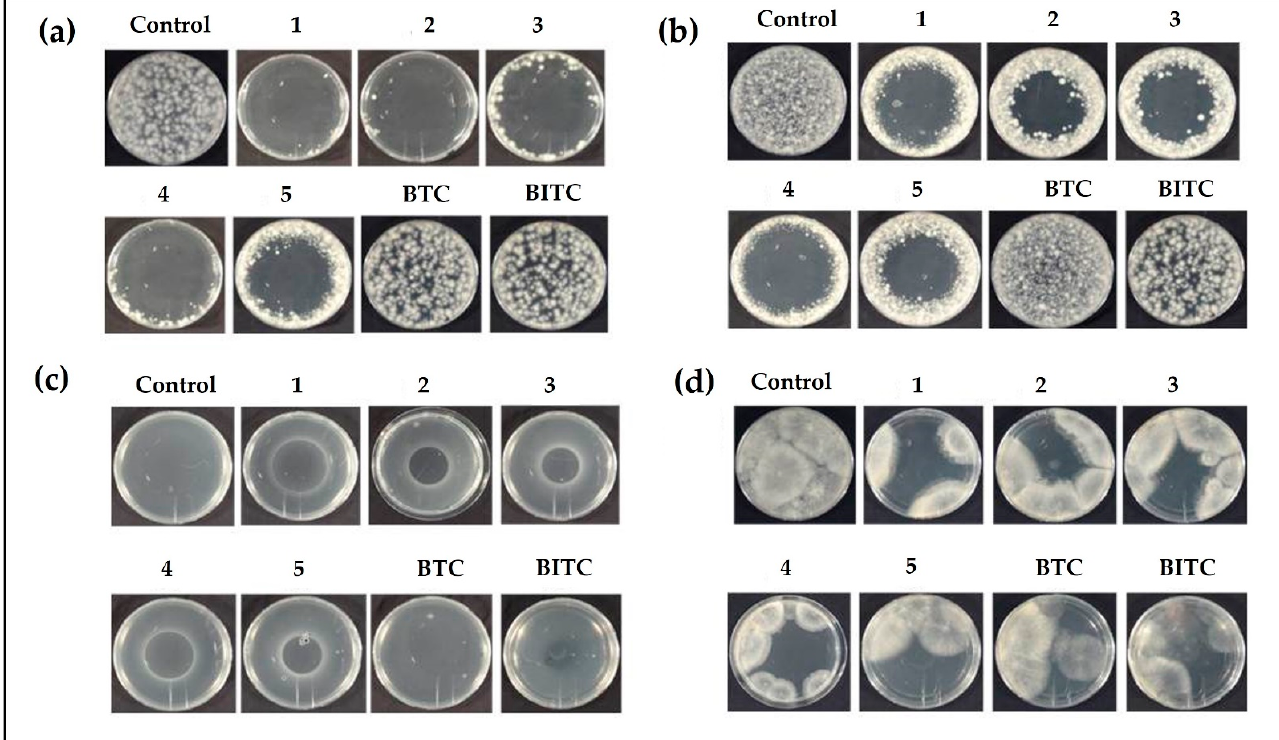
Figure 5. Antifungal activities of selenocyanates and thiocyanates via the gas phase against ( a ) V. dahliae ( b ) V. longisporum ( c ) A. brassicicola and ( d ) B. cinerea .